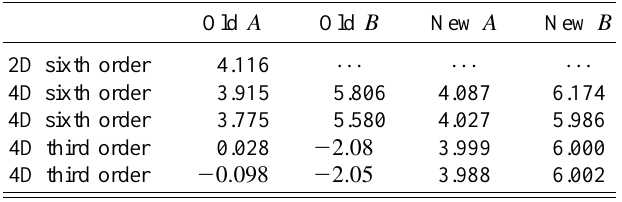
TABLE IV. Fixed points used and results of their residues: final solution.